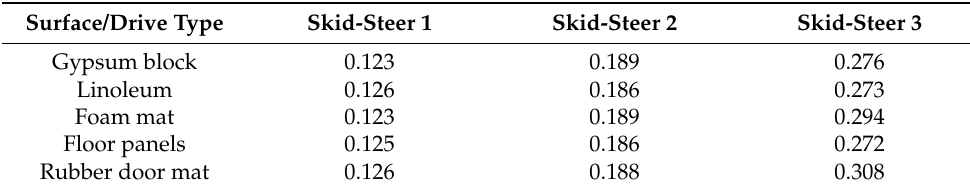
Table 7. The calculated y 0 coefficient (m) for different robot and surface types. Surface/Drive Type